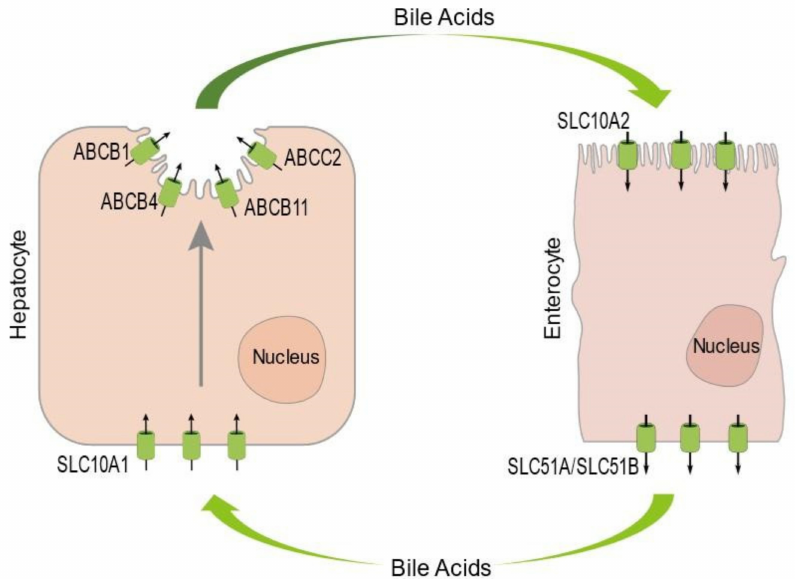
Figure 1. Cartoon illustrating the entero-hepatic circulation of bile acids, the polarized distribution of the canalicular proteins ABCB1, ABCB4, ABCB11 and ABCC2 and the basolateral protein SLC10A1 in hepatocytes, and the polarized distribution of the brush border protein SLC10A2 and the baso- lateral proteins SLC51A and -B in enterocytes. Arrows indicate direction of movement (see text for further